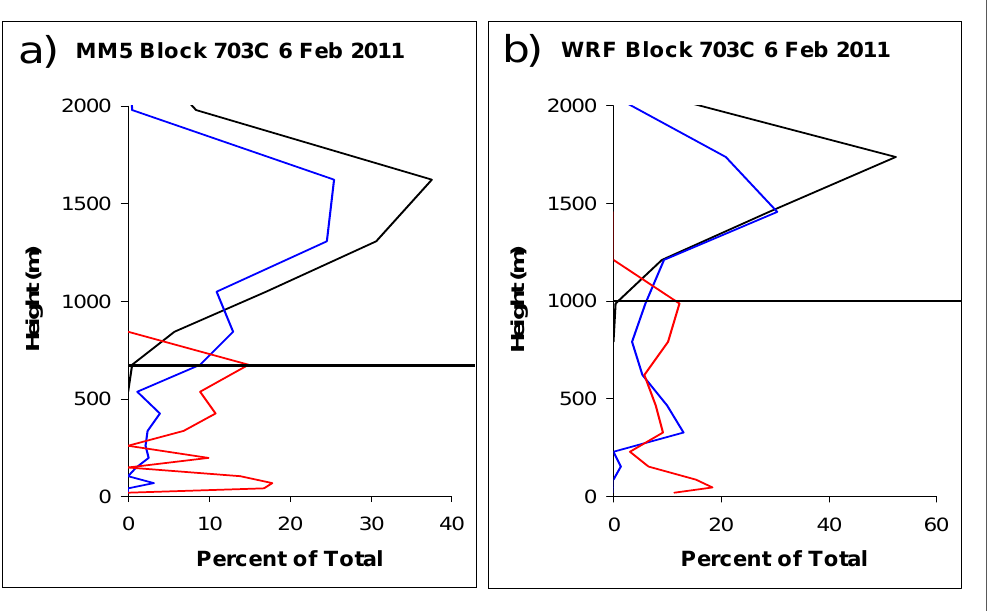
Figure 15. For the Daysmoke simulation done with the ( a ) MM5 and ( b ) WRF soundings: Vertical distribution of smoke within normalized by layer thicknesses and expressed as a percentage of the total smoke passing through a wall of an 11 km radius cylinder for 13:00 LST (black line), 14:00 LST (blue line) and 15:00 LST (red